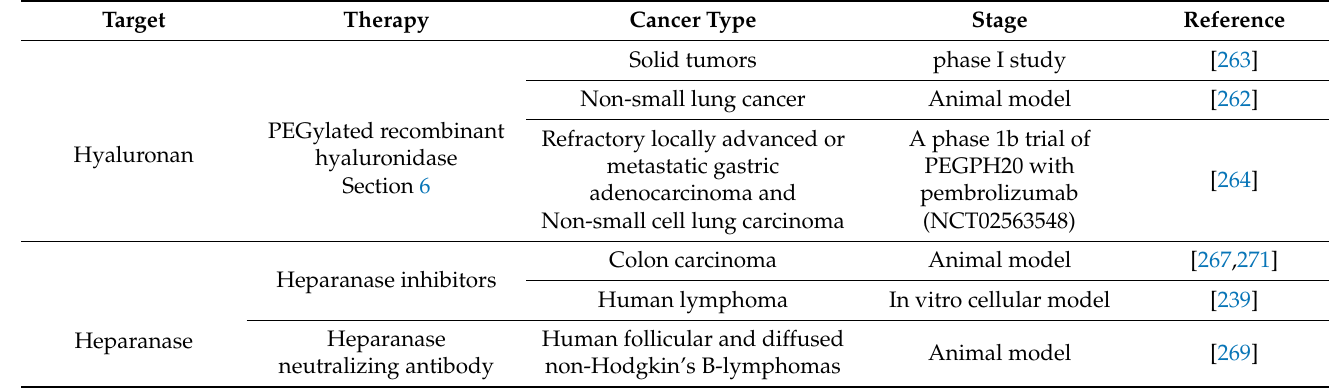
Table 4. Developing GAG-associated